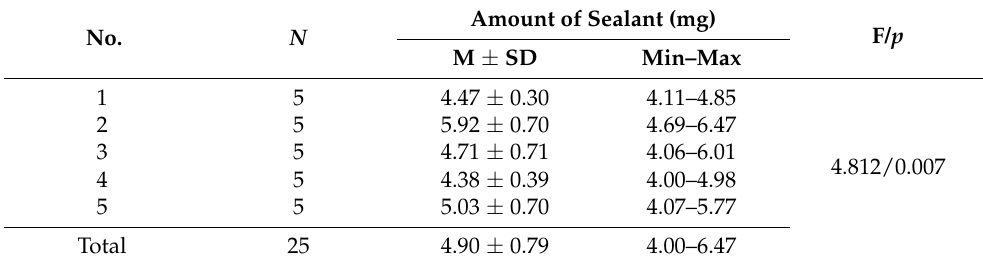
Table 2. Amount of sealant applied to the first molar models.